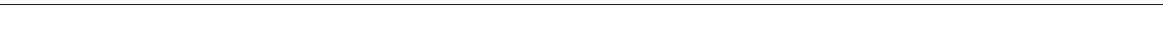
Fig. 1 NLRP3 is modi fi ed by SUMO-2/-3. a Schematic representation of the six predicted SUMO-conjugation motifs ( ψ KXE) and SUMO-interaction motif (SIM) in the NLRP3 protein. b Left-hand side, details of the SUMO-conjugation motifs and summary of prediction software scores. Analysis using R. Hay website provides motif type (S = strict and R = relaxed). Conservation of the predicted SUMO conjugation motifs between mouse and human NLRP3 are depicted underneath. Red boxes indicate evolutionary conserved sites, grey boxes indicate sites that are only present in humans. Right-hand side, structural prediction of NLRP3 depicting the identi fi ed SUMO motifs. The acceptor lysines shown in (a) are highlighted as red sticks. Note, K88 and K204 are in fl exible loops and hence are not part of the model. The structural prediction of NLRP3 was created using PHYRE2. c Sumoylation of NLRP3 in murine Nlrp3 − / − BMDMs and N1-8 BMDMs that were reconstituted with FLAG-tagged NLRP3 (N1-8). NLRP3 was immunoprecipitated and the presence of the indicated proteins was evaluated using the indicated antibodies. For this and all subsequent immunoblots, representative immunoblots are shown from at least three independent experiments. d Sumoylation of NLRP3 in HEK293T cells expressing FLAG-tagged human NLRP3 in the presence and absence of PR- 619. NLRP3 was immunoprecipitated and the presence of the indicated proteins was evaluated using the indicated antibodies. e Sumoylation of NLRP3 in HEK293T cells transfected with FLAG-tagged human NLRP3 and HA-SUMO-3 or SUMO3 Δ GG (non-conjugatable) control. Proteins covalently bound to HA-SUMO-3 were puri fi ed under denaturing conditions using HA-resin. The presence of the indicated proteins was evaluated by